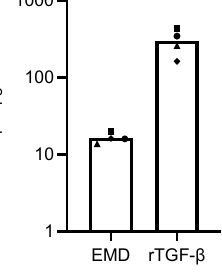
Figure 2. TGF- β immunoassay in RAW 264.7 macrophages treated with EMD or recombinant TGF- β . EMD induced TGF- β production in stimulated RAW 264.7 cells. Each data point represents an independent experiment.